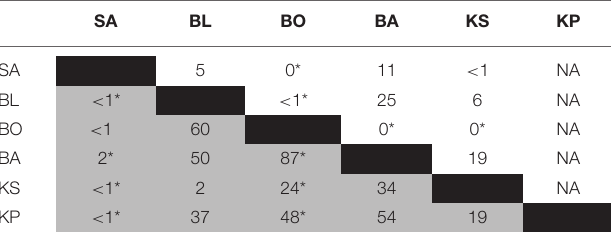
TABLE 4 | Percentage (%) of niche area (SEA) overlapping between sites for C. bleekeri (gray) and D. prosopotaenia (white).